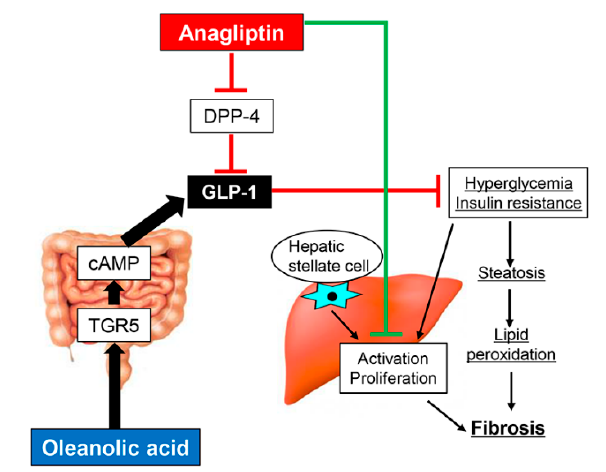
Figure 7. Schematic of antifibrotic effects of oleanolic acid and anagliptin.